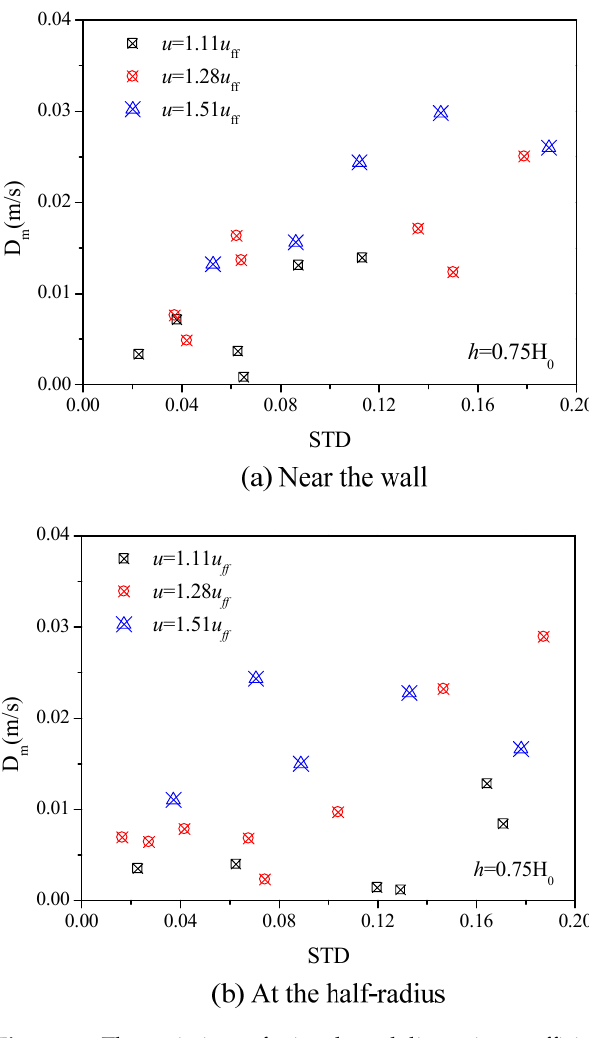
Figure 10. The variations of micro lateral dispersion coefficient of particles with STD at different gas velocities. ( a ) Near the wall. ( b ) At the